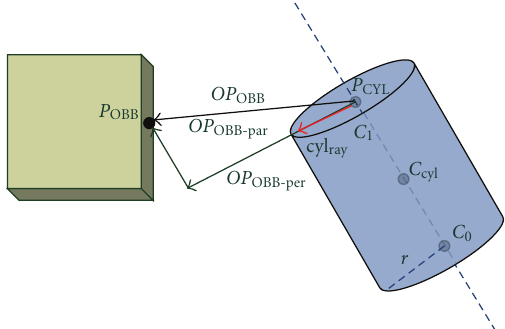
Figure 8: Principles of the intersection test between an OBB and a cylinder.